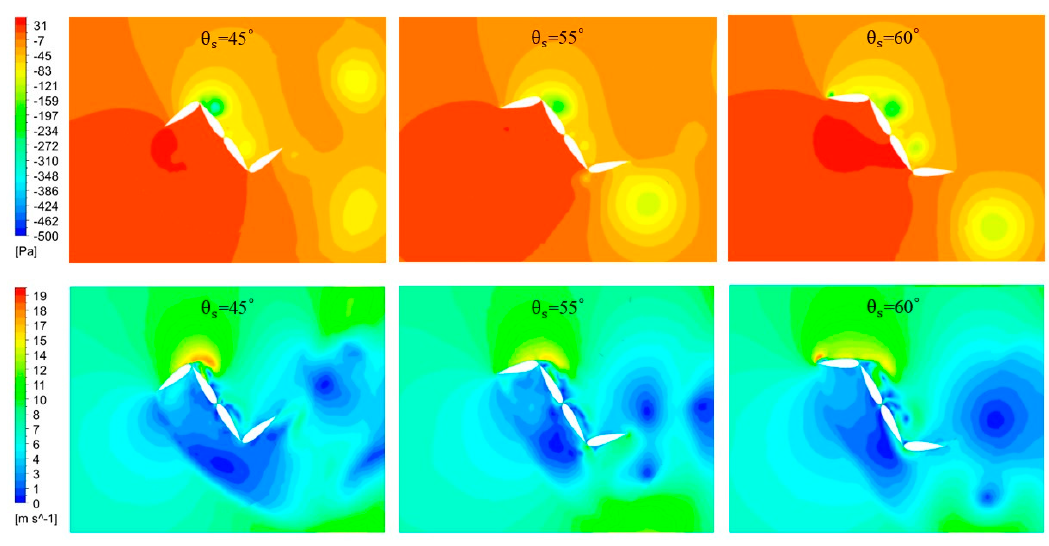
Figure 7. Instantaneous pressure (top) and velocity (bottom) contours at TSR = 0.6 for the three Savonius configurations at θ = 100°.